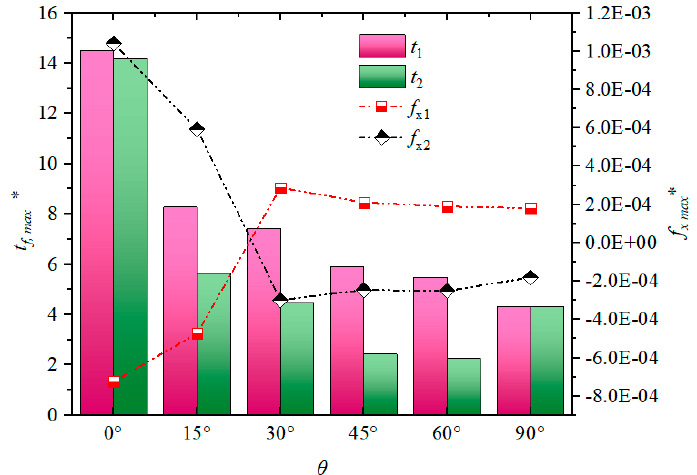
Figure 12. Maxima of the dimensionless horizontal force acting on particles 1 and 2 (right axis) and the dimensionless times that the maxima occurred.